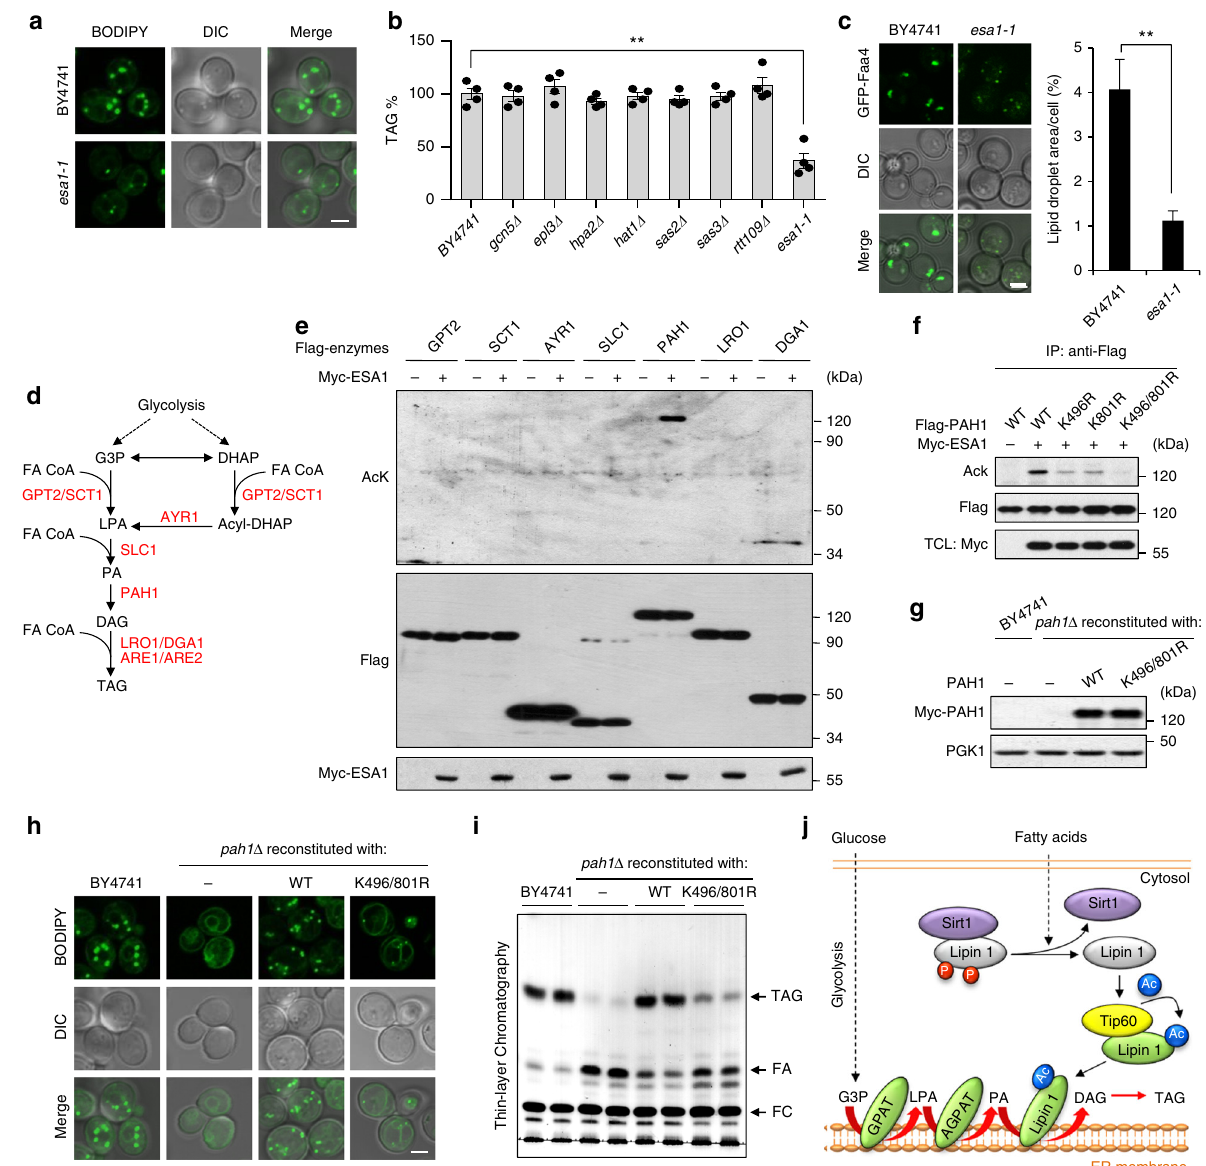
Fig. 7 Essential roles of Tip60 and Tip60-mediated lipin 1 acetylation in TAG synthesis in S. cerevisiae . a Representative images ( n = 3 replicate experiments) of BODIPY staining of WT (BY4741) and ESA1 (yeast Tip60) loss-of-function mutant ( esa1-1 , an auxin-sensitive mutant strain of ESA1 ) cells grown in synthetic complete (SC) medium. DIC differential interference contrast microscopy images. Scale bar, 2 μ m. b Identi fi cation of ESA1 as essential gene for TAG accumulation in yeast. TAG was extracted from cells grown in SC medium, separated by thin-layer chromatography (TLC) and quanti fi ed ( n = 4 experiments). c Decreased lipid droplet (LD) formation in esa1-1 mutant strain. Representative images ( n = 3 replicate experiments) of cells expressing chromosomally GFP-tagged fatty acid activation protein 4 (Faa4) (a LD marker protein) were grown in SC medium and analyzed ( n = 100 cells quanti fi ed for each group). Scale bar, 2 μ m. d TAG synthesis pathway in S. cerevisiae . e ESA1 speci fi cally acetylates PAH1 but not other enzymes in the TAG